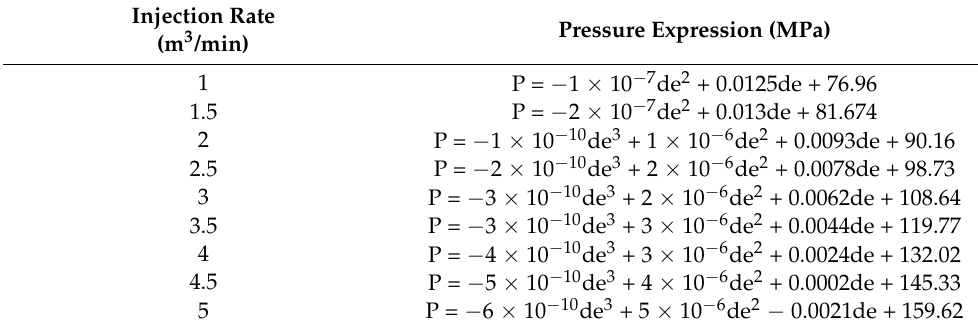
Table 3. The fitting formulas of pressure distribution in the tubing string under different injection rates (pressure is defined as P, de is